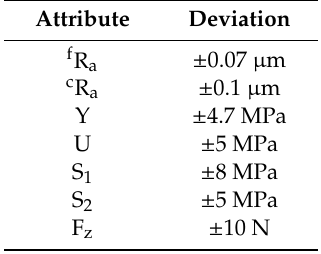
Table 2. Maximum standard deviations in various experimental